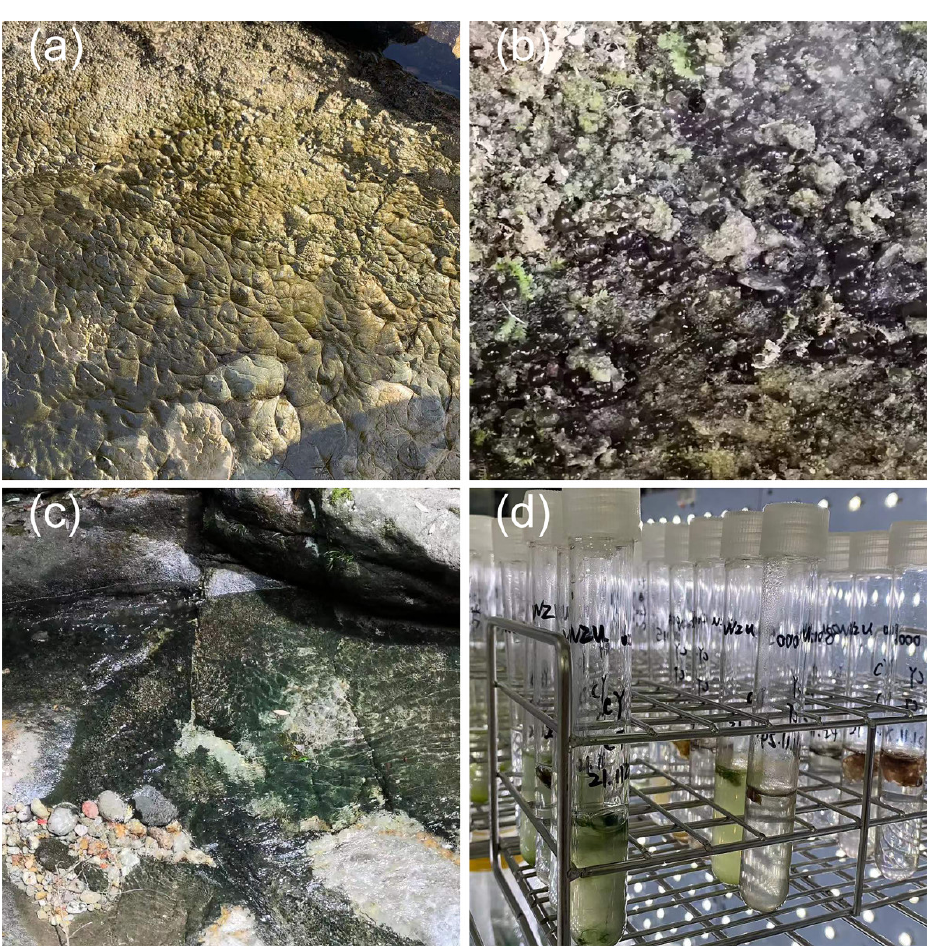
Figure 1. The habitats of studied strains. ( a ) Benthic mat samples near to riverbank including Phor- midium -like sp. 1 strains. ( b ) Soil samples including Phormidium -like sp. 2 strains. ( c ) Benthic mat samples at the bottom of the streams including Phormidium -like sp. 3 strains. ( d ) Macroscopic view of all WZU strains.